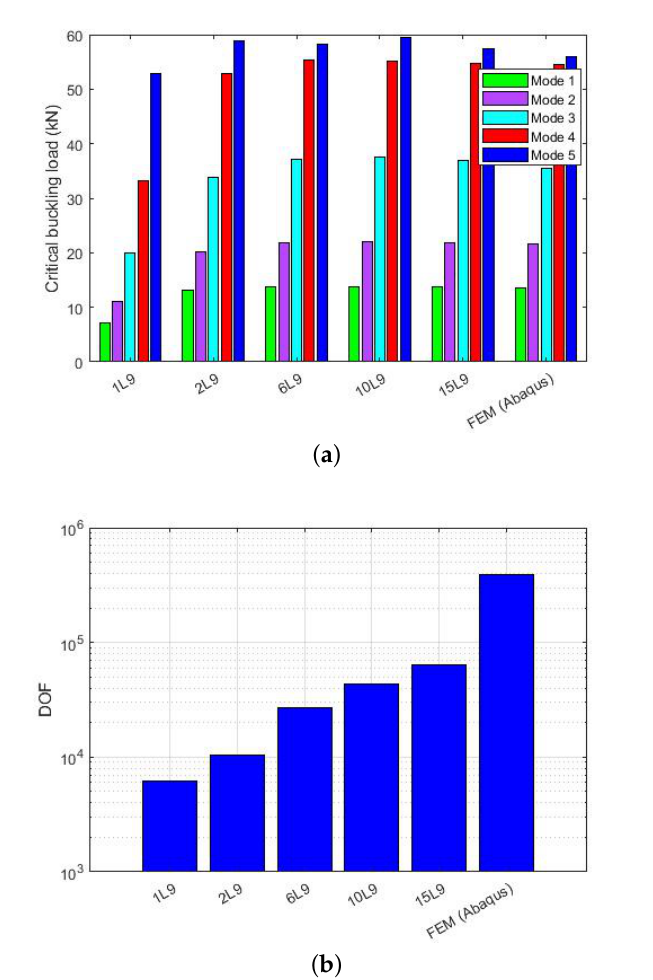
Figure 6. 1D CUF cross-section refinement with 10 B 3 influence on buckling load in VAT 1 in terms of FEM and degrees of freedom. ( a ) Cross-section refinement. ( b ) DOF based on cross- section refinement.